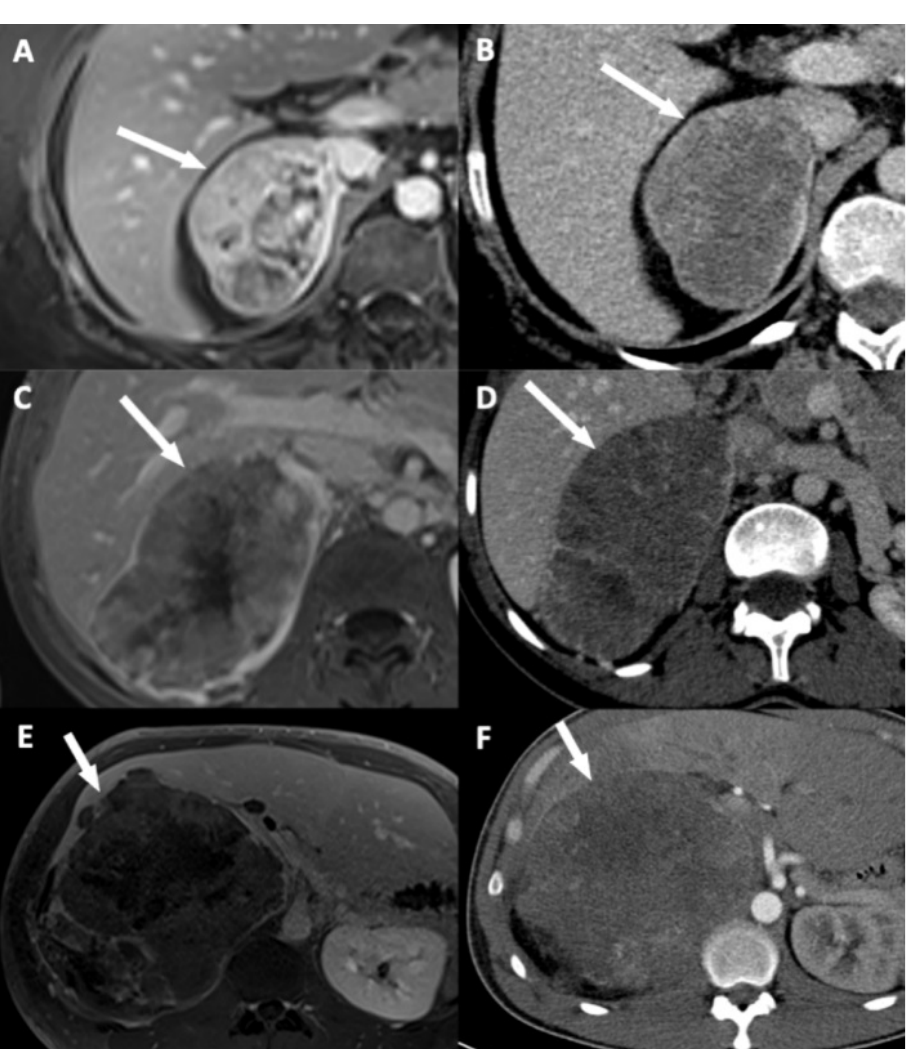
Figure 4. Illustration of adrenocortical carcinoma (ACC) contour disruption. ( A , B ) A 53-year-old woman with a right-sided ACC (Weiss score = 9, Ki67 = 40%), without direct liver involvement (DLI). ( A ) T1-weighted 3D VIBE image in the transverse plane obtained during the venous phase following intravenous administration of gadoterate meglumine shows a thin marginal enhancement of the